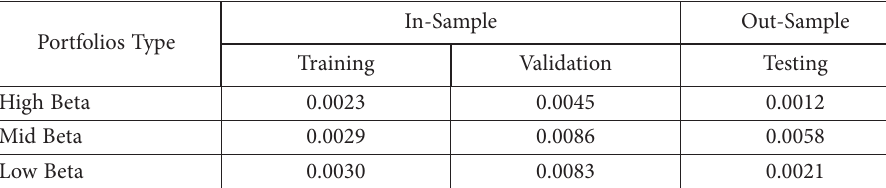
Table 4. In-Sample and Out-Sample MSE Statistics of FF5F